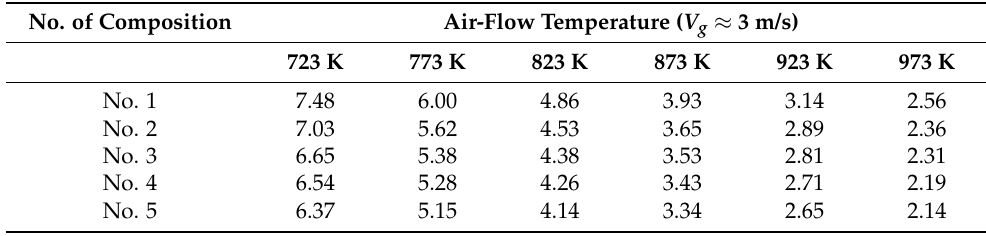
Table 4. Average ignition-delay times of CLF exposed to convective heating ( V g ≈ 3 m/s) at different air temperatures